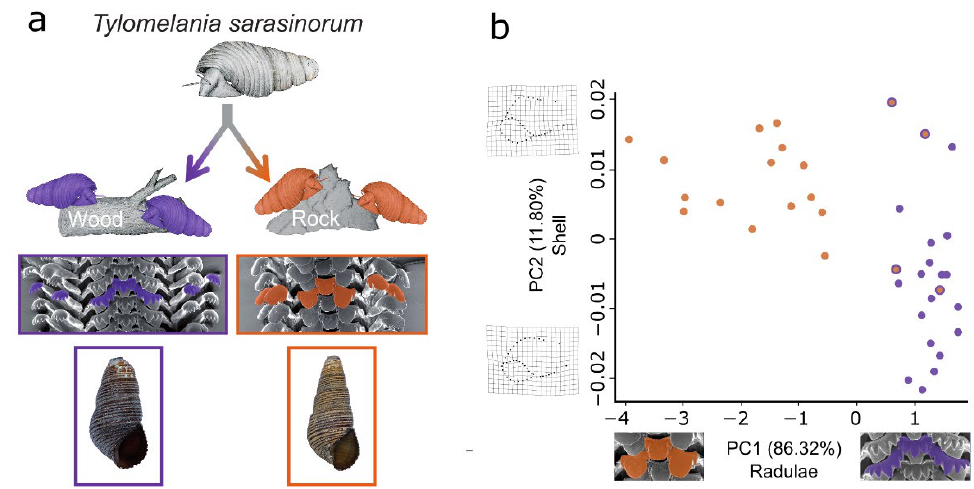
Figure 2. Habitat-correlated radula polymorphism in T. sarasinorum . ( a ) Illustrates the hypothesis that radulae of T. sarasinorum evolved in adaptation to different microhabitats giving rise to diverging ecomorphs. ( b ) Scatterplot based on the two principal components of shell and radula shape that differed significantly between wood (purple) and rock (orange) ecomorphs. PC1 of radula shape is displayed on the x -axis and PC2 of shell shape on the y -axis. Thin plate splines visualize the variation in shell shape explained by PC2. The center of each dot indicates the habitat, whereas the outer ring indicates the ecomorph based on SEM inspection of the radula.